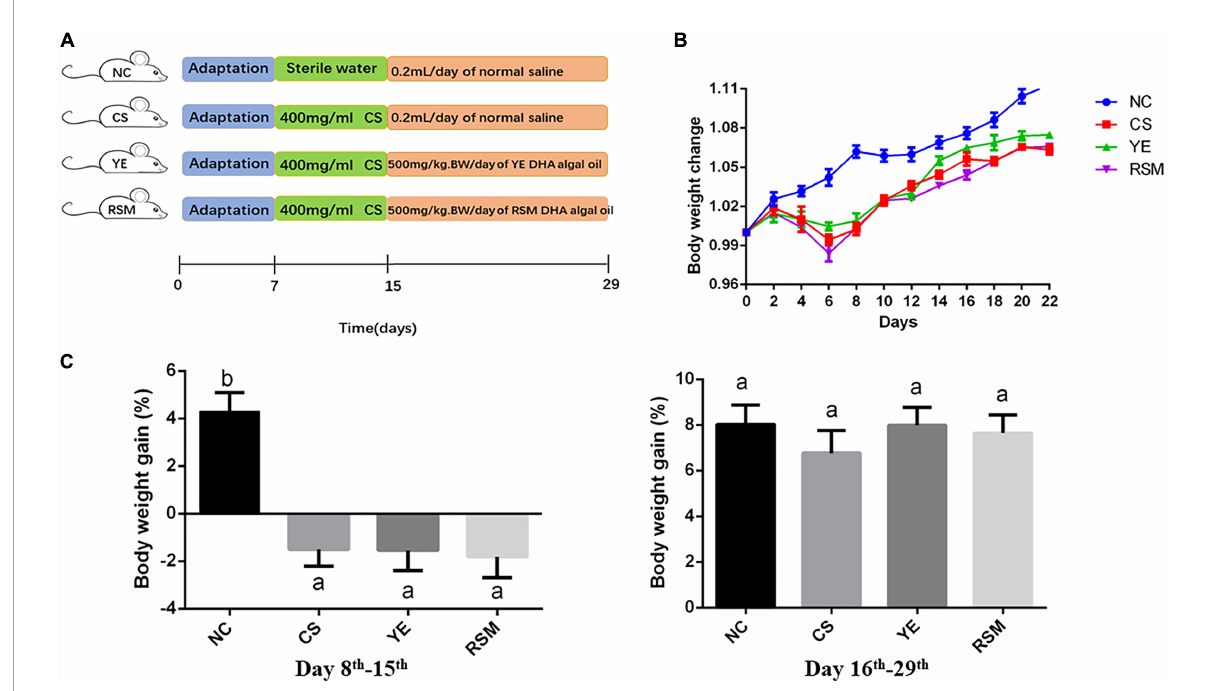
FIGURE1 Effect of two kinds of algal oil on clinical symptoms in CS-treated mice. (A) Scheme of the animal experimental design. (B) Body weight change during the experiment. (C) Body weight gain on day 8th–15th and day 16th–29th. Data ( n = 9 per group) are expressed as mean ± SEM; groups with different letters statistically differ. Groups with the same letter are considered to have no significant differences, groups with different letters are significantly different from each other ( P <